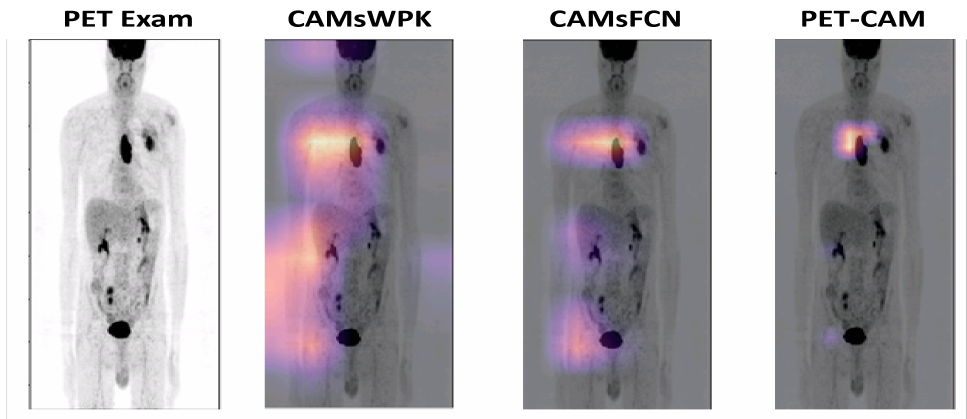
Figure 9. Comparison between different models. From left to right: PET exam, CAMs without prior knowledge using CNN, CAMs without prior knowledge using FCN, our proposed PET-CAM model. PET-CAM tends to focus on a region near the region of interest, while standard CAM may look at different organs or outside the